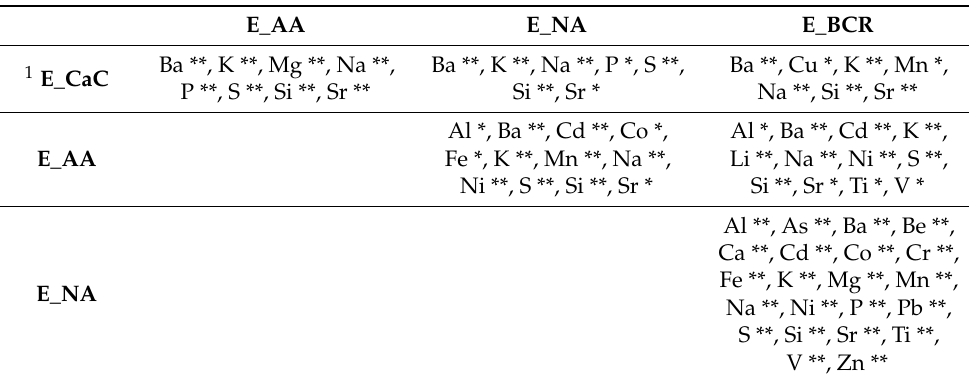
Table 7. Correlation analysis of extracted element